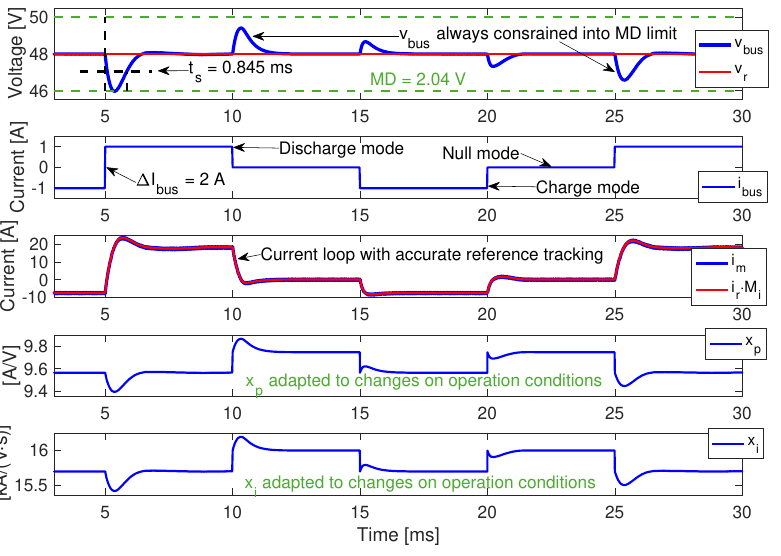
Figure 10. Circuital simulation of the double adaptive PI structure in